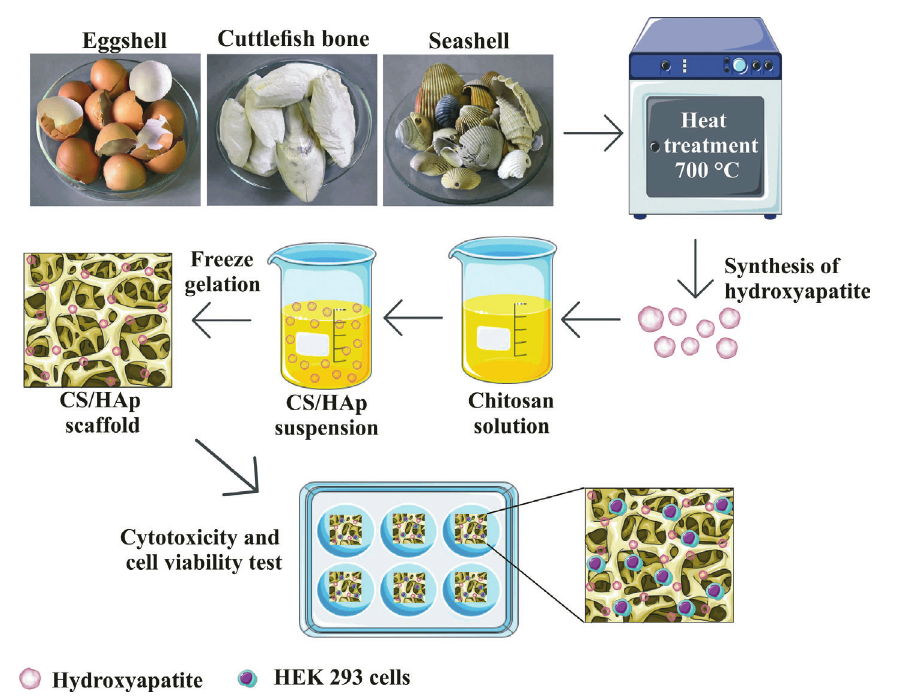
Fig. 1 – Schematic diagram of the synthesis of composite chitosan/hydroxyapatite scaffolds obtained from eggshell, cuttlefish bone, and